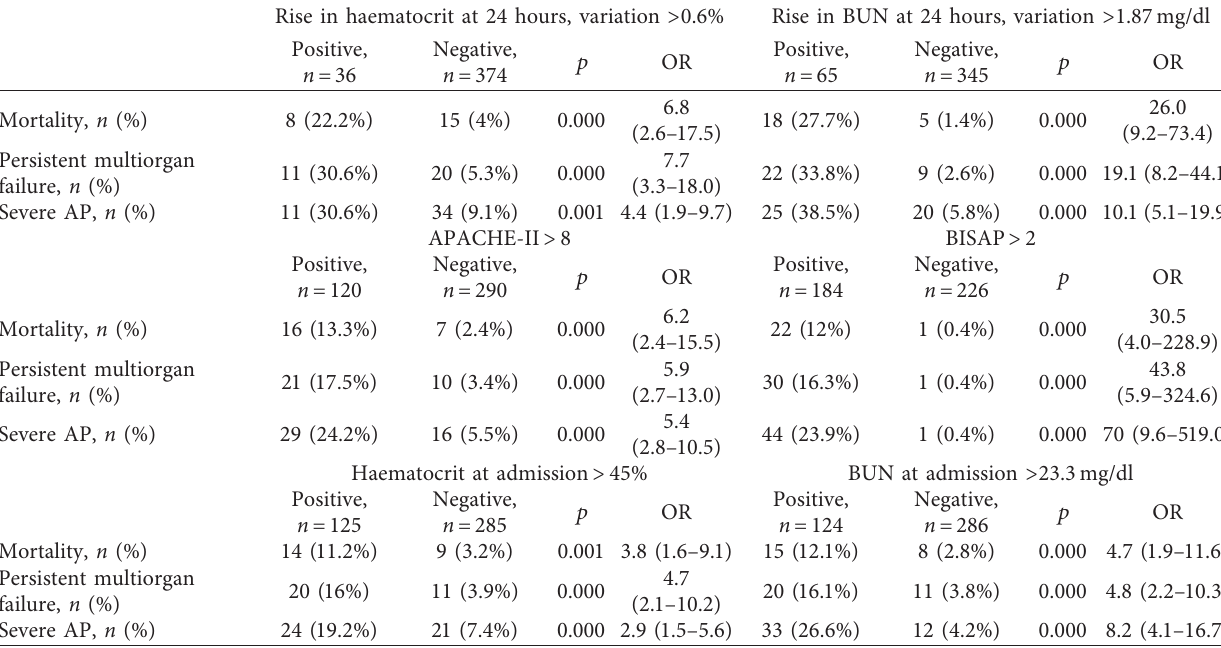
Table 2: Outcomes of AP according BISAP, APACHE-II, BUN, and